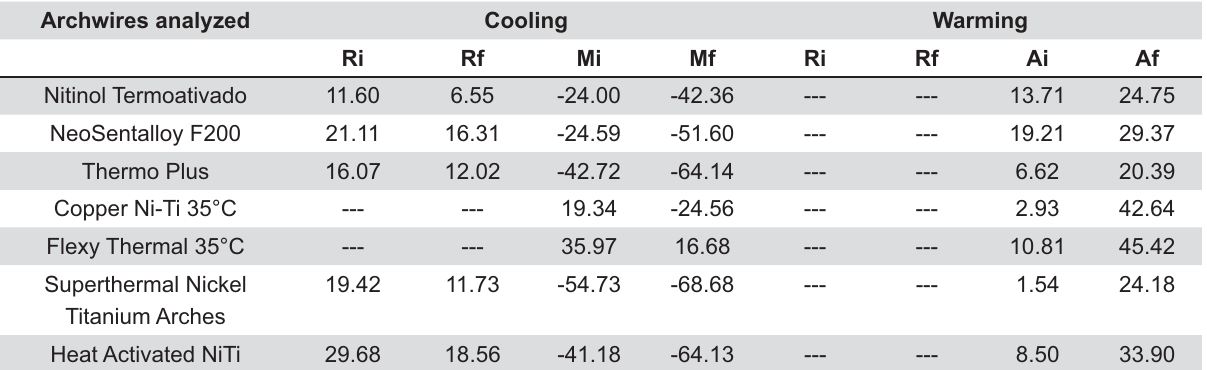
Table 1- Transition temperatures (°C) of thermally activated NiTi archwires